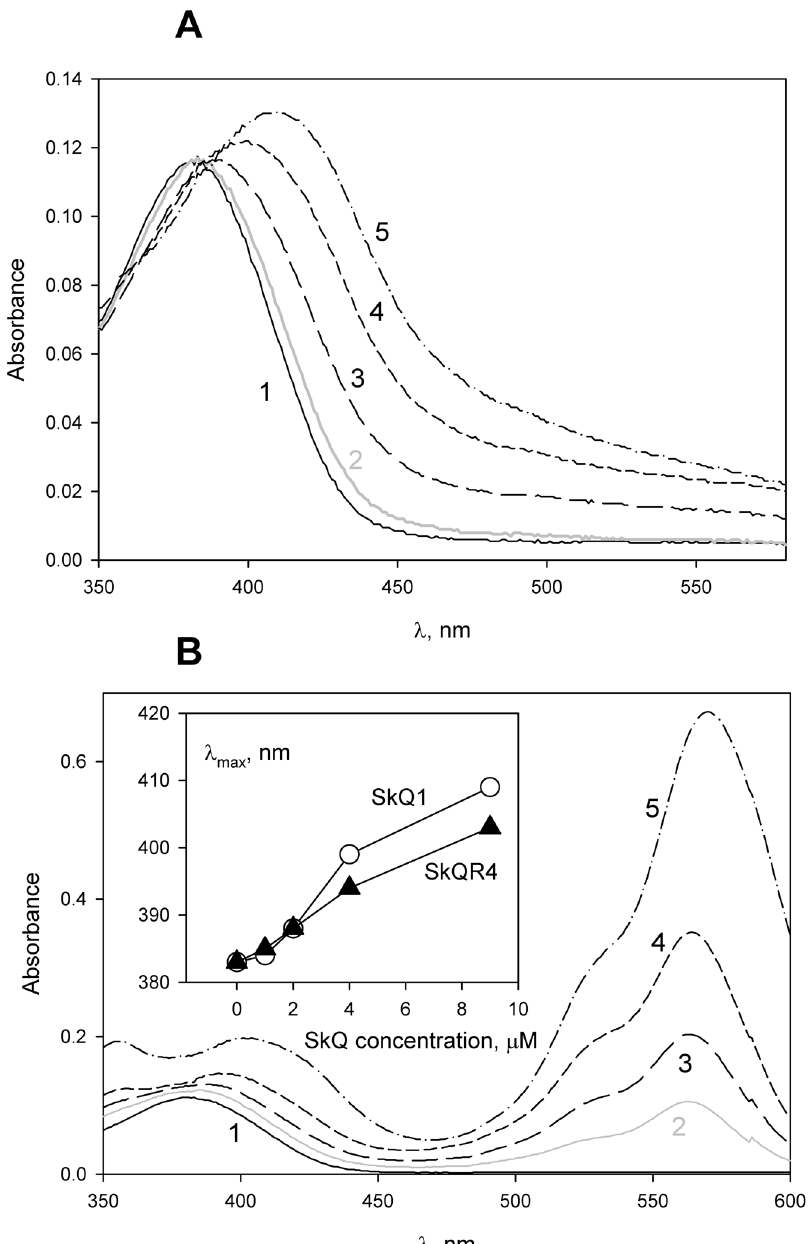
Figure 4. SkQ1 (10-(6-plastoquinonyl)decyl triphenylphosphonium) affects absorption spectra of CCCP in the presence of liposomes. Incubation mixture: 4 m M CCCP, 1 mM Tris, 1 mM MES, pH=7.4, containing DPhPC (diphytanoylphosphatidylcholine) liposomes (20 m g/ ml) in the absence (curve 1) and in the presence of 1 m M, 2 m M, 4 m M and 9 m M SkQ1 (panel A, curves 2–5, respectively) or in the presence of 1 m M, 2 m M, 4 m M and 9 m M SkQR4 (panel B, curves 2–5, respectively). Insert to panel B shows the dependence of l max on the concentration of the SkQ derivatives.